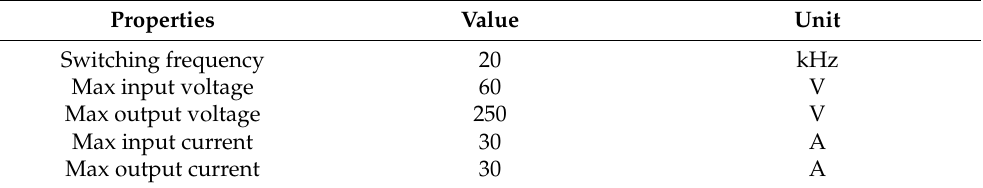
Table 2. TEP-192 Details.